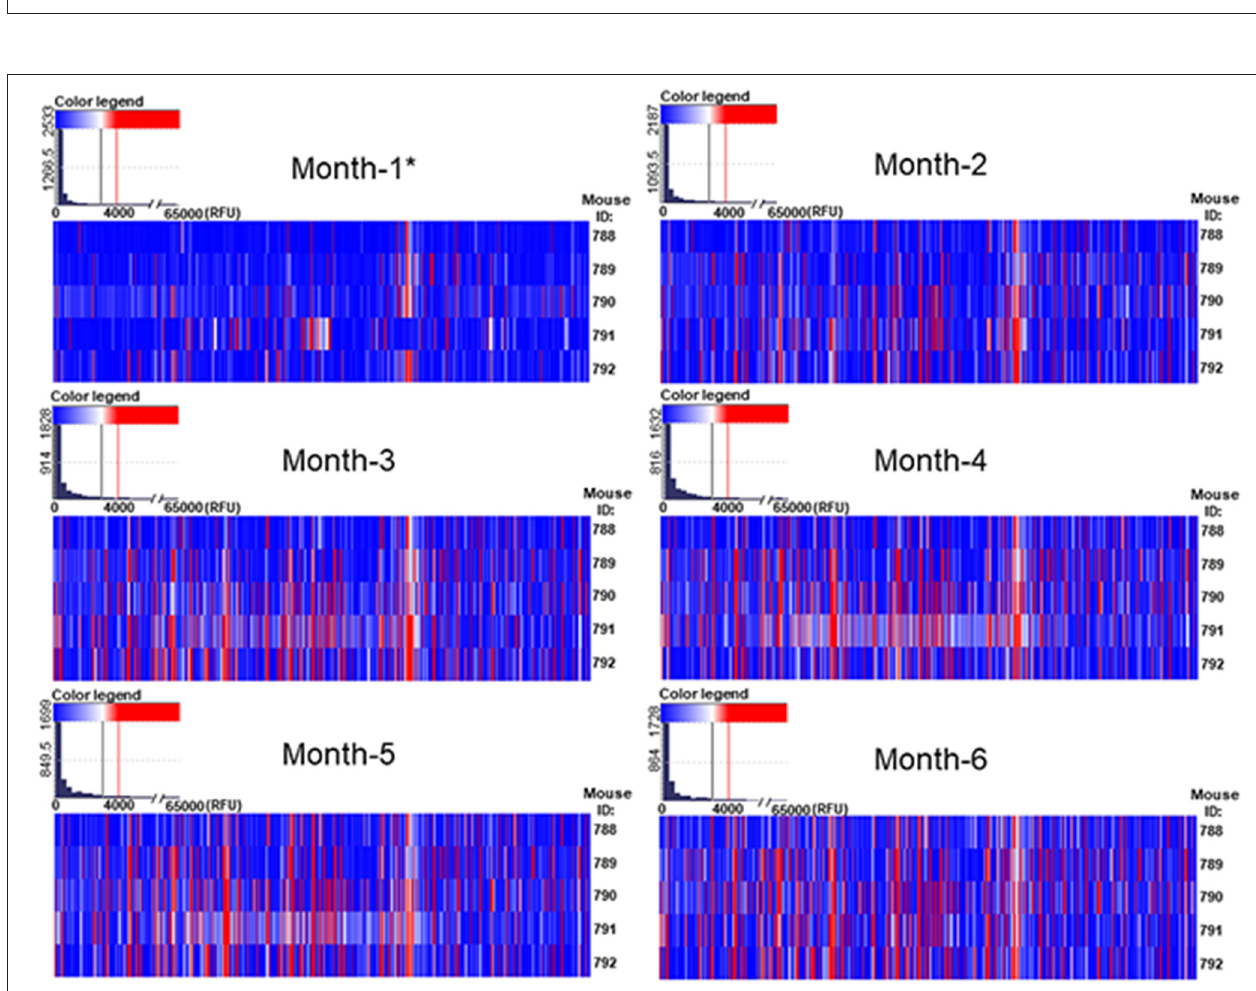
FIGURE 2 | The repertoire of natural circulating anti-carbohydrate antibodies in GalT-KO is a function of age. GalT-KO mouse ( n = 5) serum (1:15) was incubated with chips printed with 682 different glycans (6 replicates). Chips were scanned using a ScanArray GX Plus reader and data were analyzed with the ScanArray Express Microarray Analysis System (PerkinElmer). The binding results for IgM + IgG + IgA were expressed in RFU as the median ± IQR (25–75th). In the heat map, blue and white colors represent binding signals in RFU lower than 4,000 (background); red color signals ≥ 4,000 RFU (positive binding). *3 weeks of age.